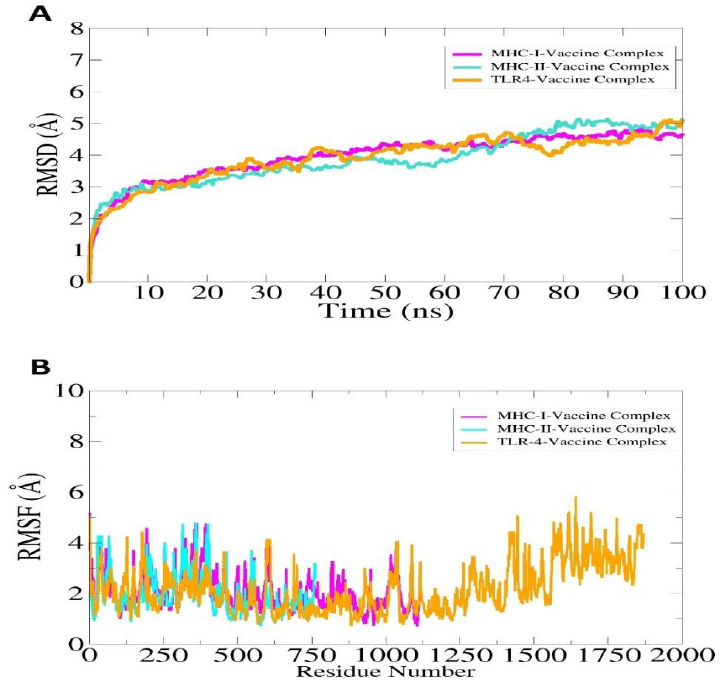
Figure 11. Simulation trajectories analysis of the vaccine-immune receptors. RMSD ( A ) and RMSF ( B ). In the case of RMSF, the TLR-4 length is from Glu1 to Asn1478, MHC-I length is from Gly1 to Met599, and MHC-II is from Glu1 to Ser519. The afterward residues in ease case till the end represent the vaccine molecule.